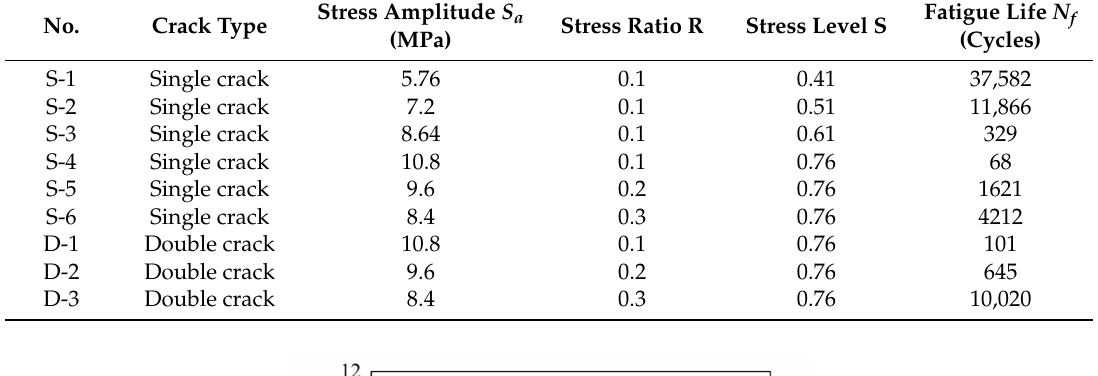
Table 2. Fatigue test results.